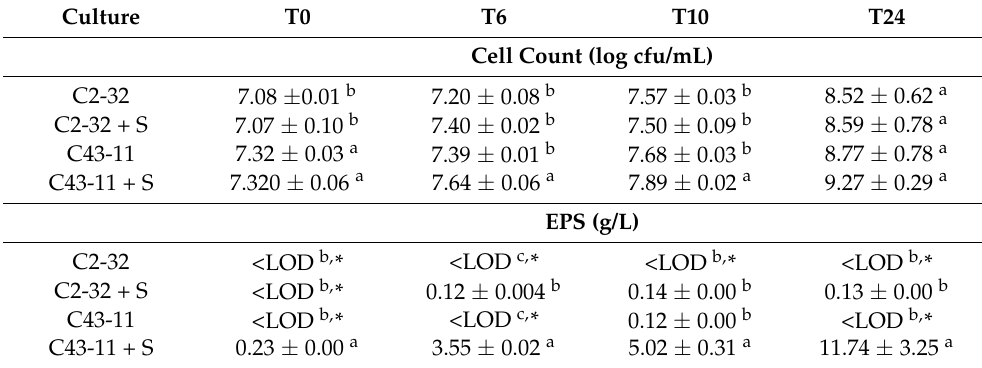
Table 1. Cell count (log cfu/mL) and EPS production by W. cibaria C43-11 and C2-32 in mMRS with (+S) or without sucrose after 0 h, 6 h, 10 h, and 24 h incubation at 30 ◦ C.